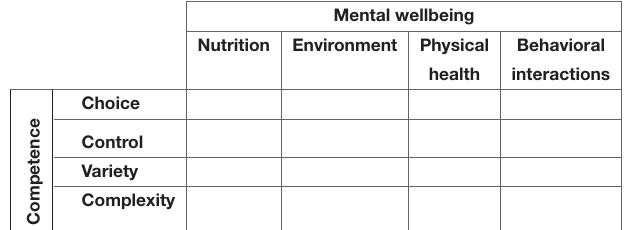
TABLE 1 | The welfare through competence design opportunities